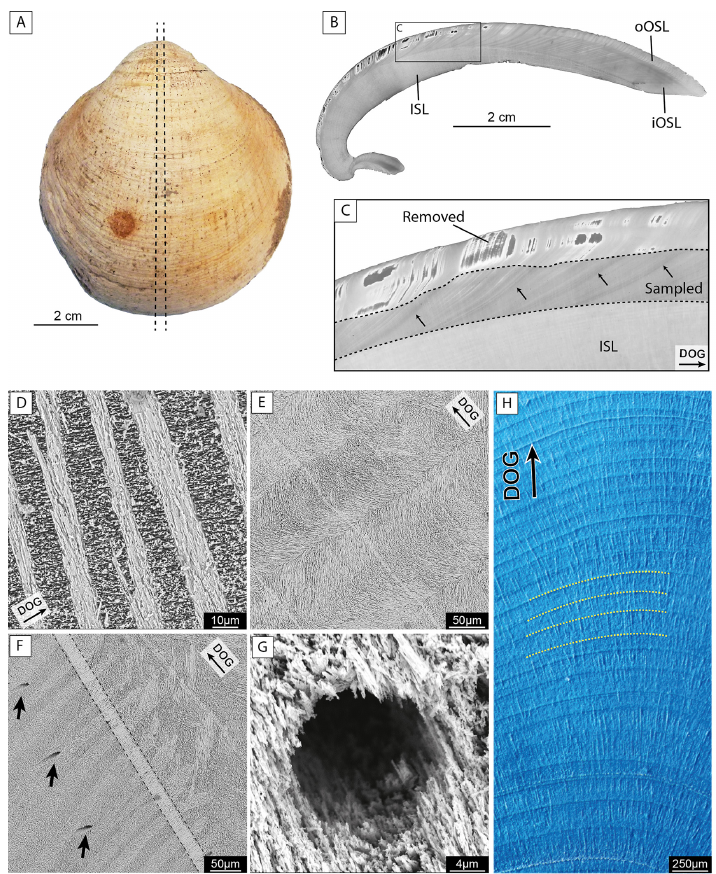
Figure 2. Macroscopic and microscopic views of the studied shell material ( Glycymeris planicostalis ) from the Early Oligocene of the Mainz Basin. (a) Left valve. Dotted lines show the cutting axis. (b) Outer and inner portions of the outer shell layer (oOSL, iOSL) as well as the inner shell layer (ISL) are clearly visible in the umbo-ventral margin cross section (dotted line in A) of specimen EOW-MB-Wht-7. (c) Carbonate powder was collected from the outer shell layer after removing the outer chalky shell portions. Arrows point to annual growth lines. (d–g) SEM images show the extraordinary preservation state of the studied shell material. Primary microstructures are still present. (d) Outer crossed-lamellar layer, (e) inner complex crossed-lamellar layer and (f) transition zone between outer and inner shell layer (dotted lines). Arrows point to tubule openings. (g) Detailed view of a tubule. The lack of diagenetic fillings inside the cavity further supports the absence of any significant diagenetic overprint. (h) Distinct growth lines (yellow dotted lines) are visible in the hinge plate of Mutvei-stained cross sections. DOG stands for direction of